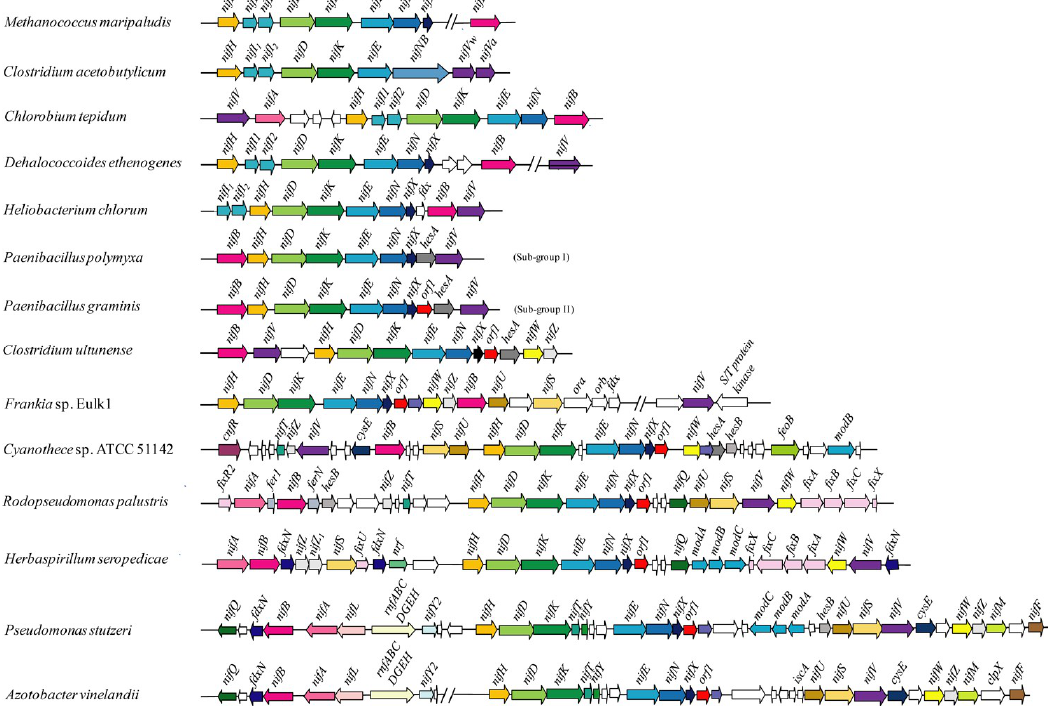
Figure 1. Comparison of the nif gene clusters from the representatives of anaerobic, facultative anaerobic, and aerobic N 2 -fixing microorganisms. Sequence of the identified regions was retrieved from GenBank and used to draw the diagram. Genes of the same color in different organisms are homologous. The orf1 and its homologous genes are colored in red.